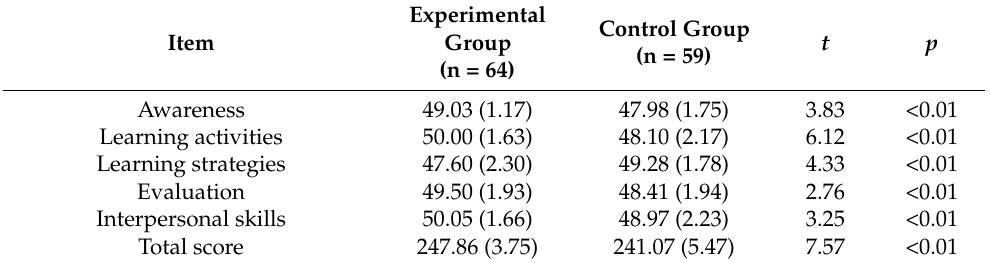
Table 2. Comparison of the SDLINS scale scores between two groups (point, M(SD)). Item